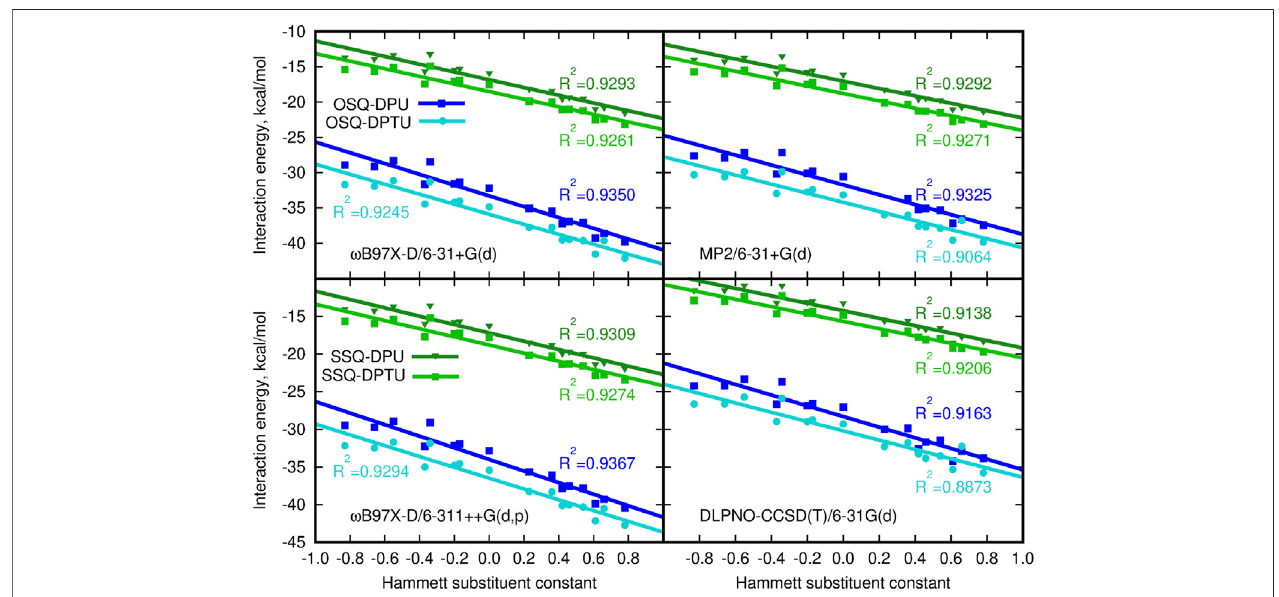
FIGURE 7 | Counterpoise-corrected supermolecular interaction energy for the three-component system calculated according to the site – site counterpoise scheme versus the Hammett substituent constant.